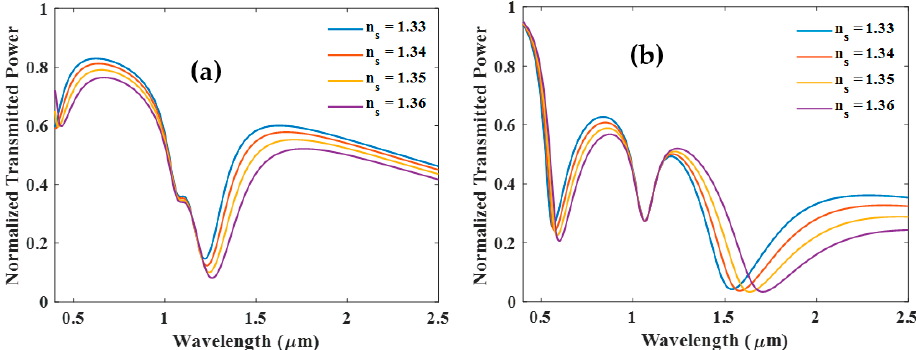
Figure 7. Normalized transmission spectra of sensing probe with ( a ) ITO (10 nm) + Ag (10 nm) + ITO (10 nm)